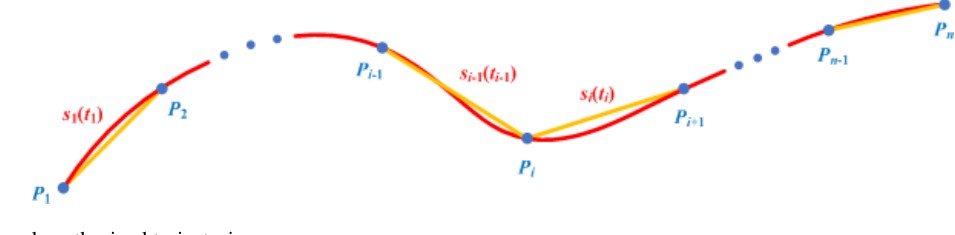
Figure 2. Path and synthesized